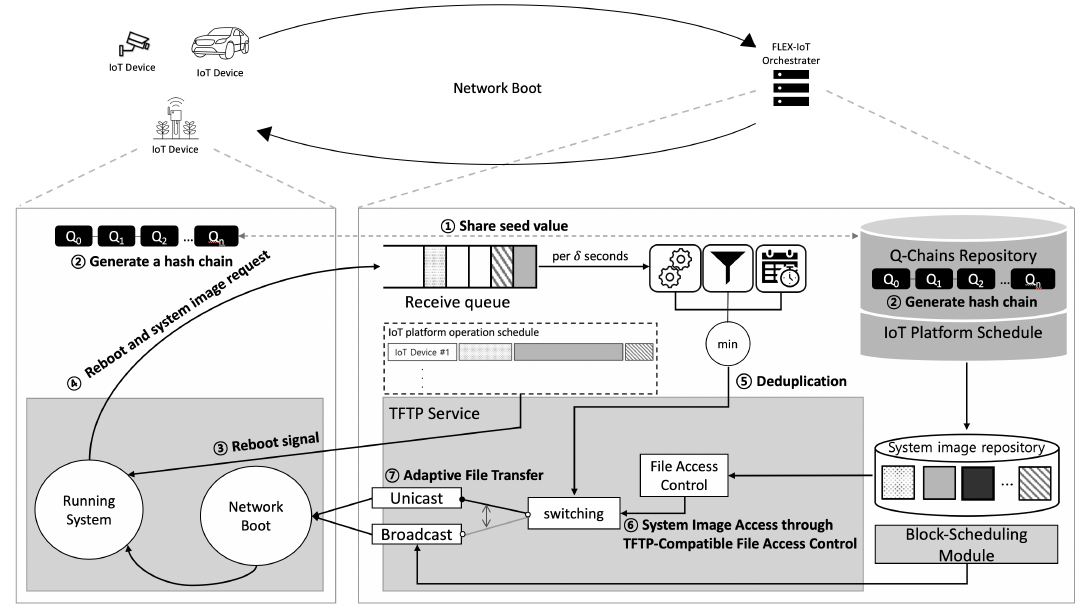
Figure 4. Overall process of the proposed